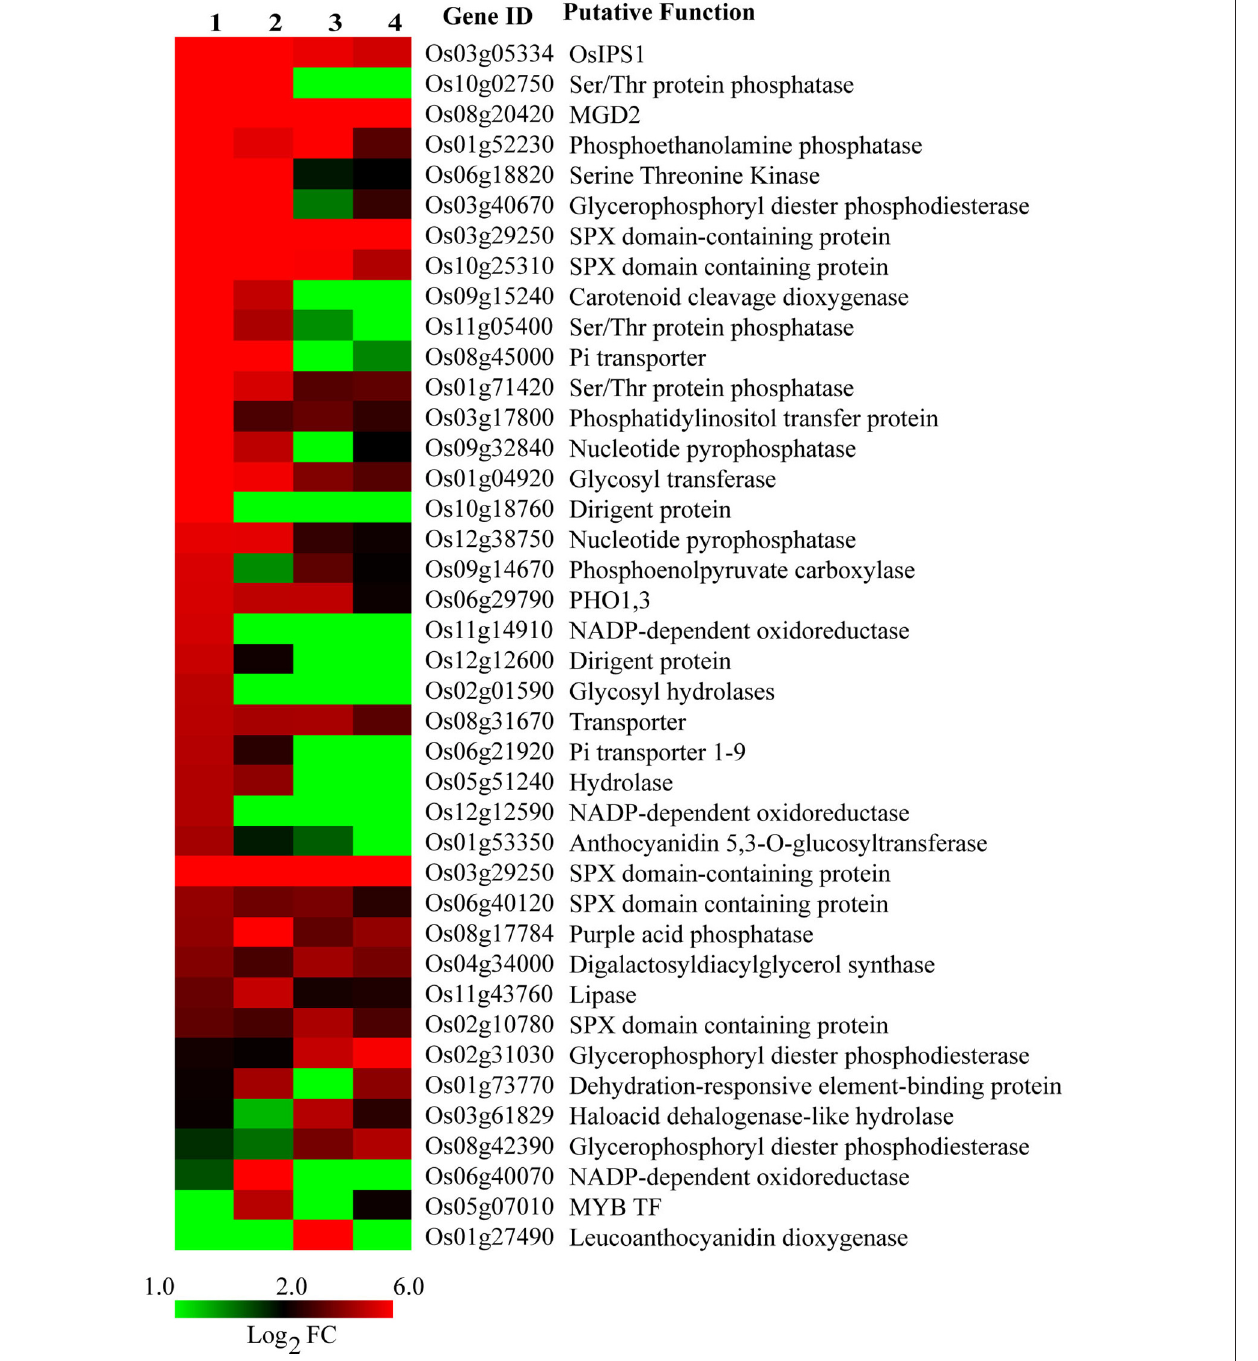
(Dular/PB1) in levels of phospholipids. Under Pi sufficient and deficient conditions, Dular shoots showed higher contents of phospholipids as compared to PB1 shoots ( Table 3 ). On the other hand, PB1 roots and shoots showed a